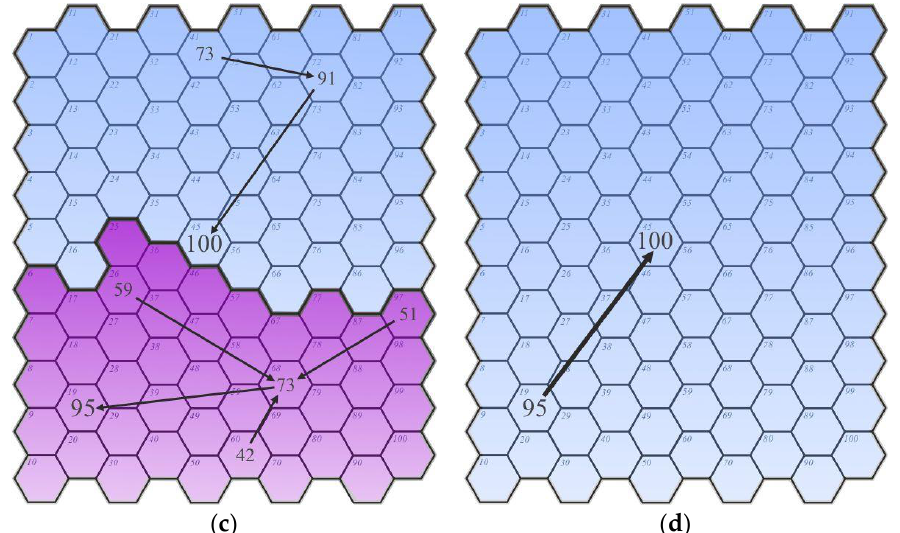
Figure 5. The stages of network emergence according to the minimum value increase path: ( a ) the stage of revealing the minimum value increase relationship; ( b ) the first stage of value aggregation; ( c ) the second stage of value aggregation; ( d ) the third stage of value aggregation. Source: Own analysis.